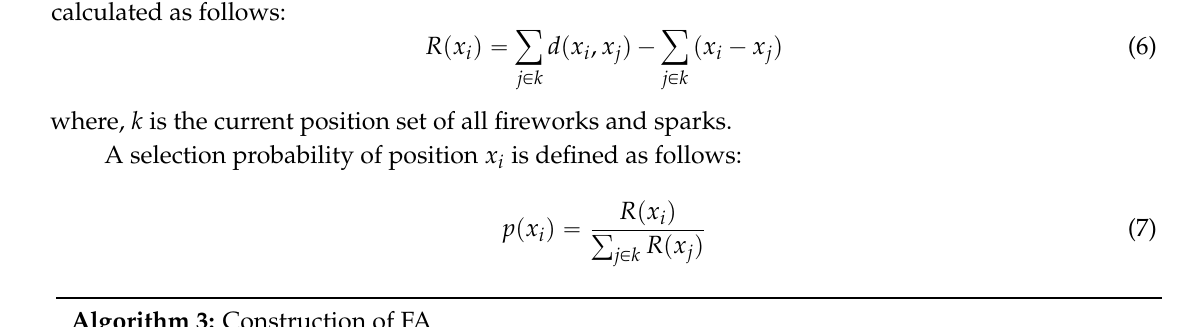
Algorithm 3: Construction of